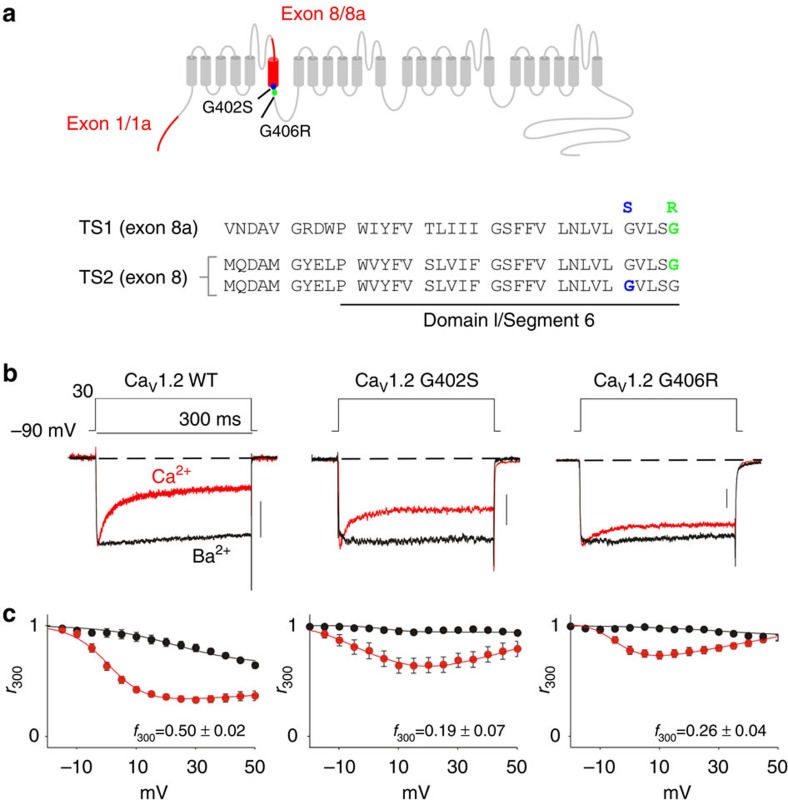
Timothy Syndrome mutations reduce CDI.(a) Diagram of Timothy Syndrome mutations within human CaV1.2. Exon 8 is expected to be paired with exon 1a in cardiac channels. (b) Exemplar whole-cell current traces in Ca2+ (red) and Ba2+ (black). CDI is seen as the faster decay of the Ca2+ versus Ba2+ trace. Channels are co-expressed with β2a to allow examination of CDI independent of VDI effects. In addition to their VDI effects, both Timothy Syndrome mutations confer a significant decrease in CDI (middle, right). Scale bars are 200 pA and refer to the Ca2+ trace. (c). Population data, the fraction of peak current remaining after 300-ms depolarization (r300) is plotted for Ba2+ and Ca2+ currents. The difference between Ca2+ and Ba2+ relations at 30 mV (f300) specifies the isolated effect of CDI. Error bars represent±s.e.m., n=10, 8 and 12 for WT, G402S and G406R, respectively.